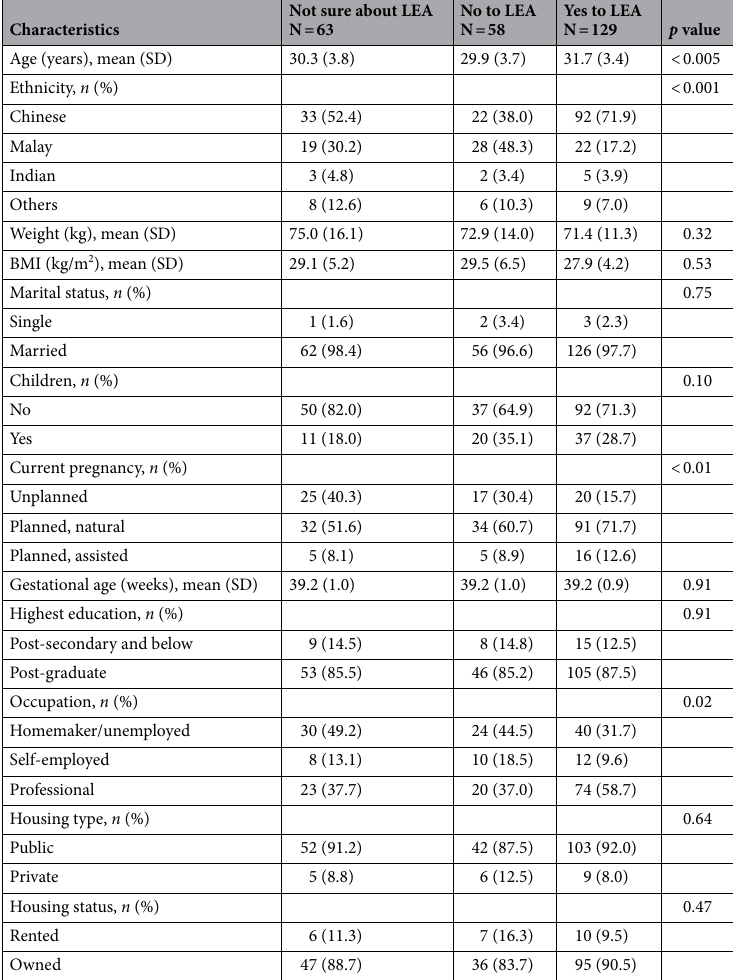
Table 1. Demographic characteristics. The missing data on demographic characteristics are as follows: Weight (n = 84), BMI (n = 85), housing type (n = 33), and housing status (n = 49). BMI body mass index; LEA labor epidural